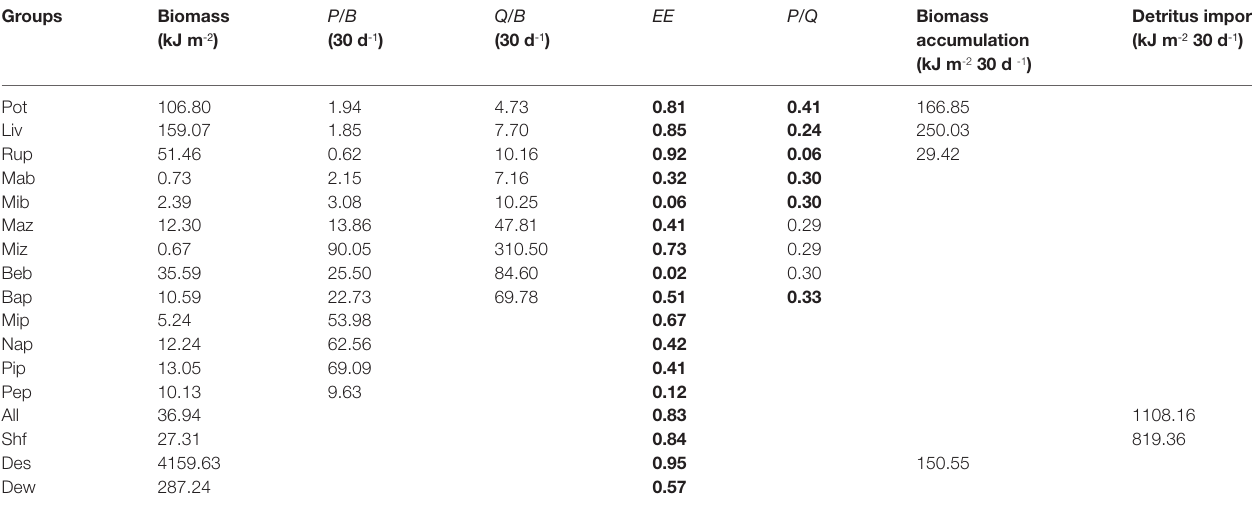
TABLE 3 | Ecopath inputs and outputs for a Portunus trituberculatus polyculture ecosystem model during the early period. Groups